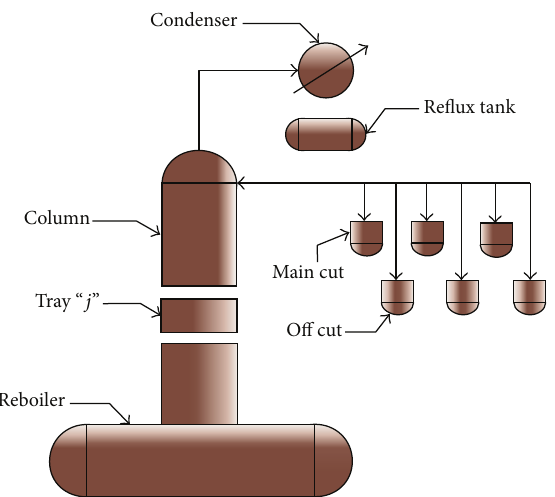
Figure 1: Batch distillation column with three receivers for products (main cut) and three receivers for mixtures (off